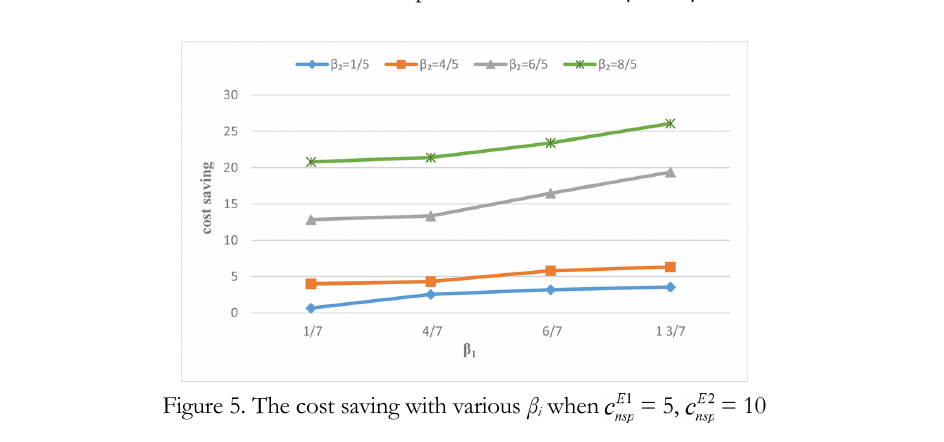
Table 6. CO * of two policies with different β